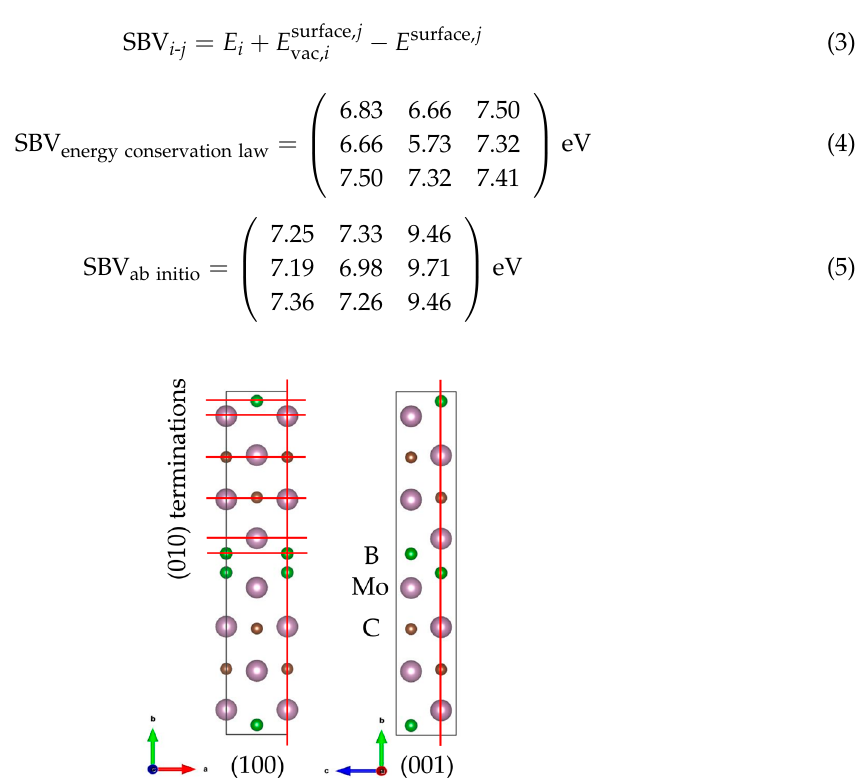
Figure 3. Considered (100), (001) surfaces and (010) surface terminations for the determination of the surface binding potentials in the ab initio approach. The colored spheres represent Mo atoms in purple, B atoms in green, and C atoms in brown. The figure was made with VESTA [46] .